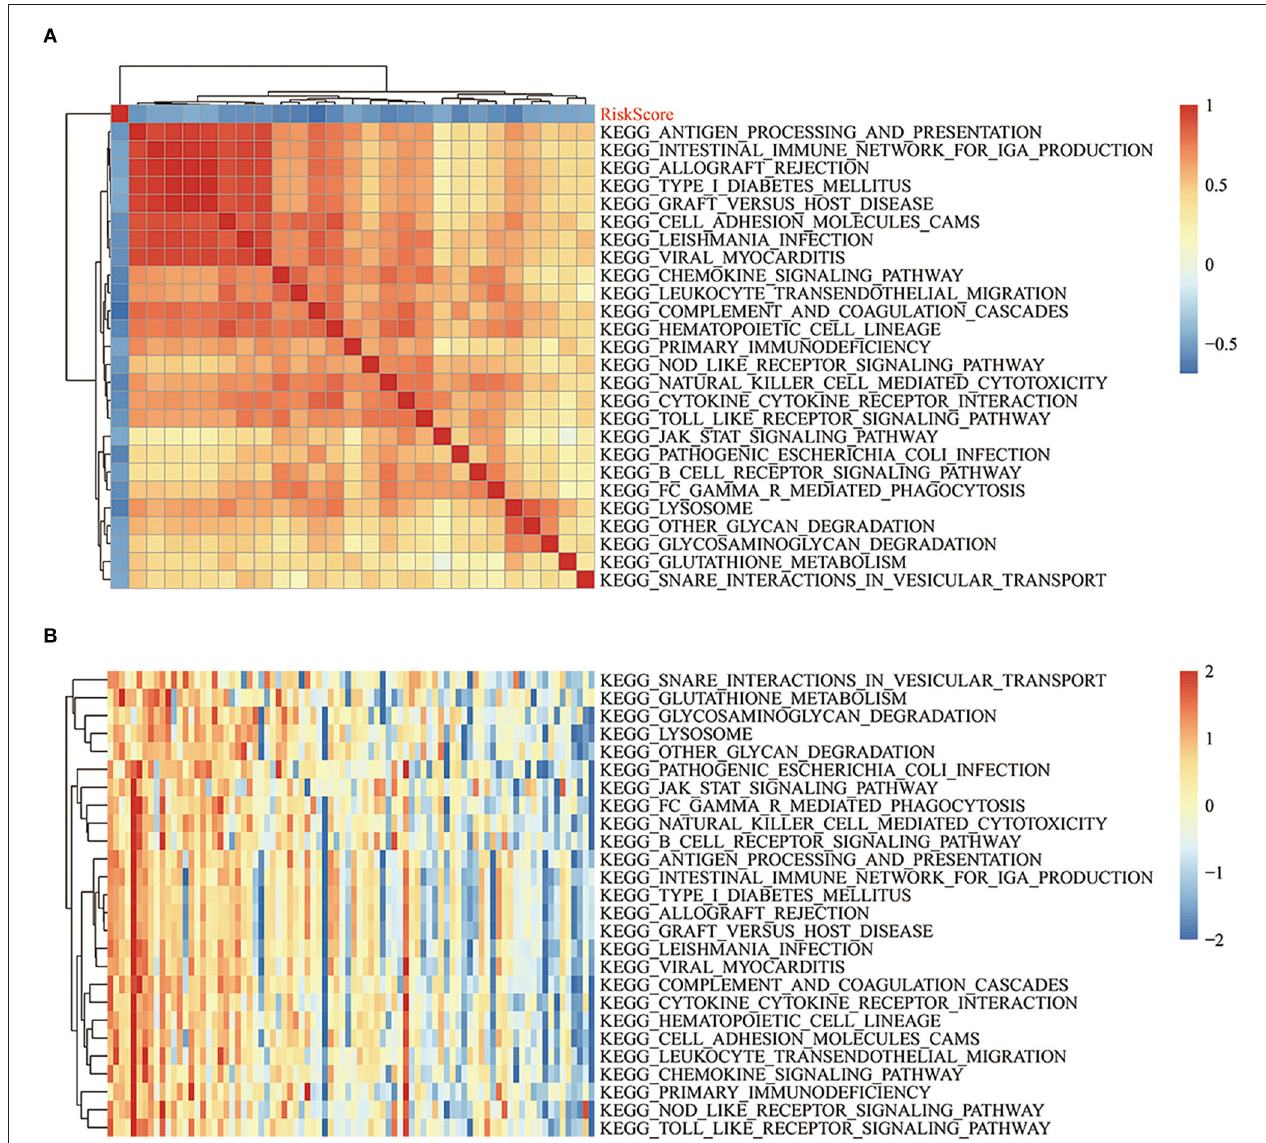
FIGURE 11 | (A) Clustering of KEGG pathways with correlation coefficients > 0.35 and risk scores. (B) ssGSEA score changes of each sample in regards to the KEGG pathways with correlation coefficients > 0.35 and increased risk scores. The horizontal axis represents the sample, and the risk score increases successively from left to right.